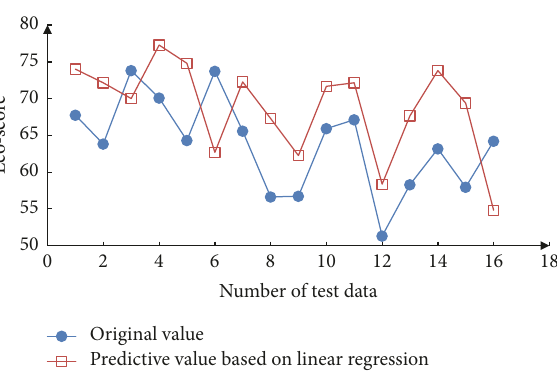
Figure 10: Relationship between original and predictive values based on random forest